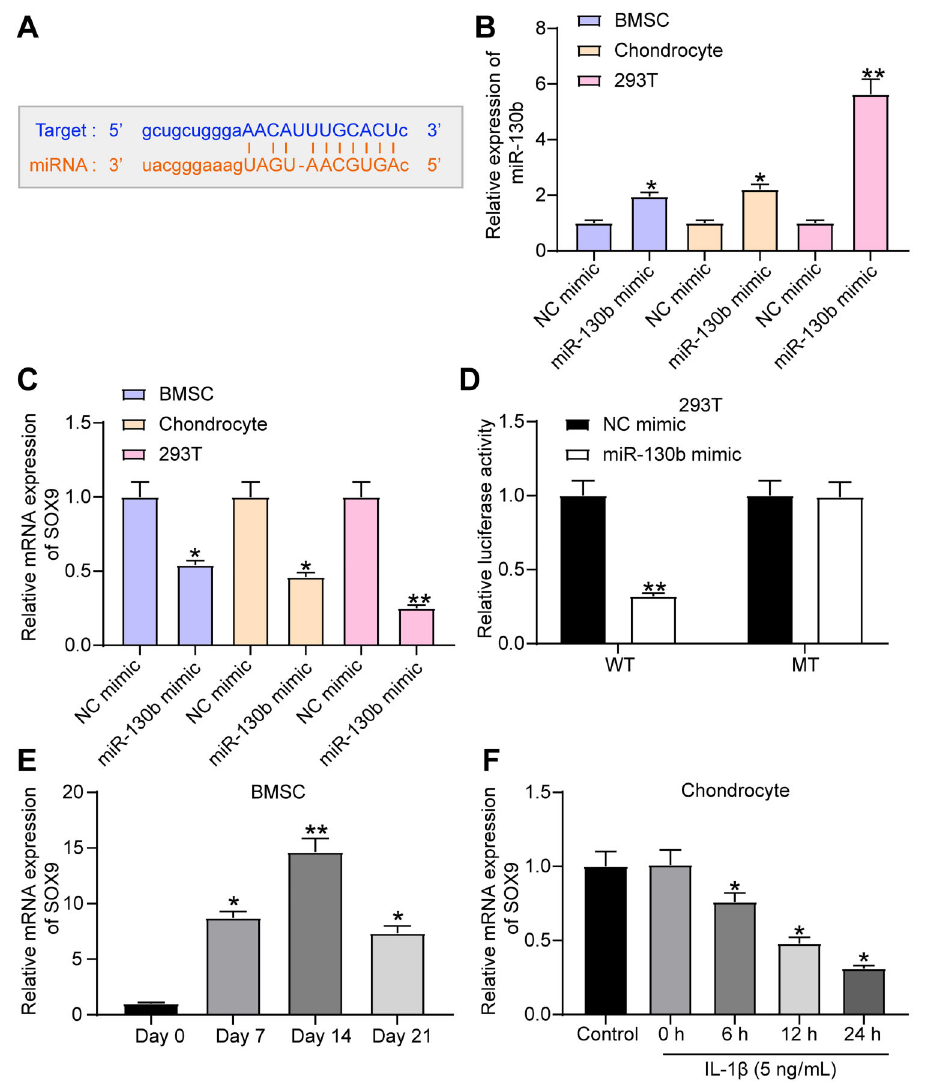
co-transfected with wild type (WT) and mutant (MUT)-SOX9 reporter plasmids, miR-130b mimic, and their controls measured by dual- luciferase reporter assay. E , SOX9 expression during chondrogenic differentiation of bone marrow mesenchymal stem cells (BMSCs) detected by RT-qPCR. F , RT-qPCR detected SOX9 expression in chondrocytes. *P o 0.05, **P o 0.01 compared to control. Data in panels B , C , E , and F were analyzed using one-way ANOVA and data in panel D were analyzed using two-way ANOVA. Experiments were repeated 3 times independently. NC: negative